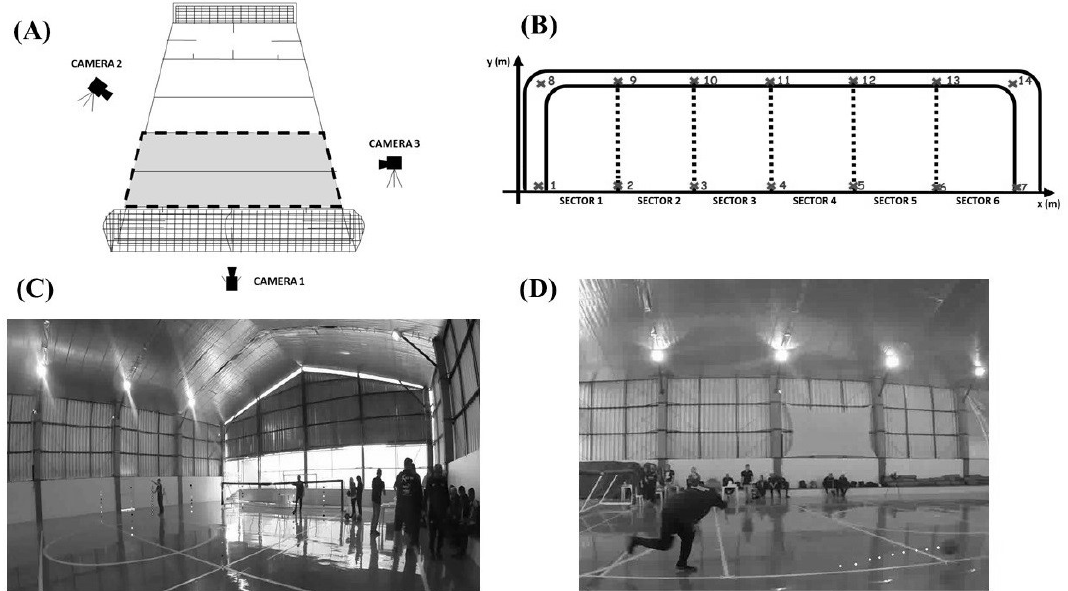
Figure 2. (A) Framing area of each video camera for accuracy and ball velocity measurements; (B) Frame of camera 1, points used for 2-D calibration and identification of the target sectors; (C) Image from camera 3 showing the displacement of ten frames from the centroid of the ball to measure velocity; and (D) Image from camera 2 of the positioning of the topographic stick to perform the 3-D